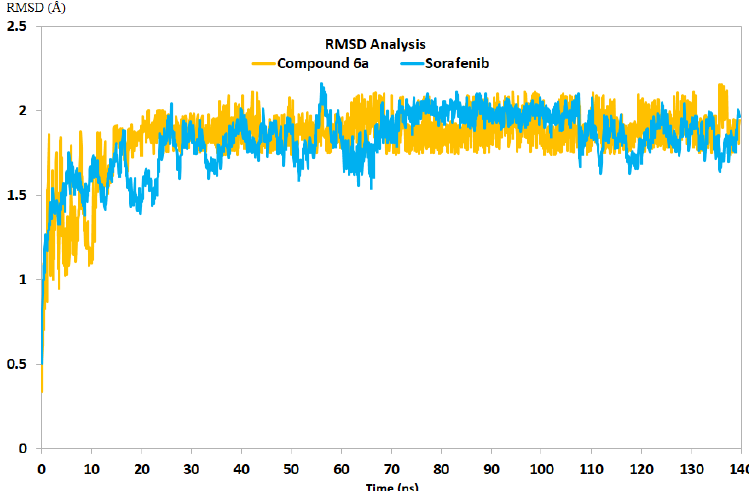
Figure 5. The RMSD values for sorafenib-VEGFR-2 (blue) and compound 7d -VEGFR-2 (orange).